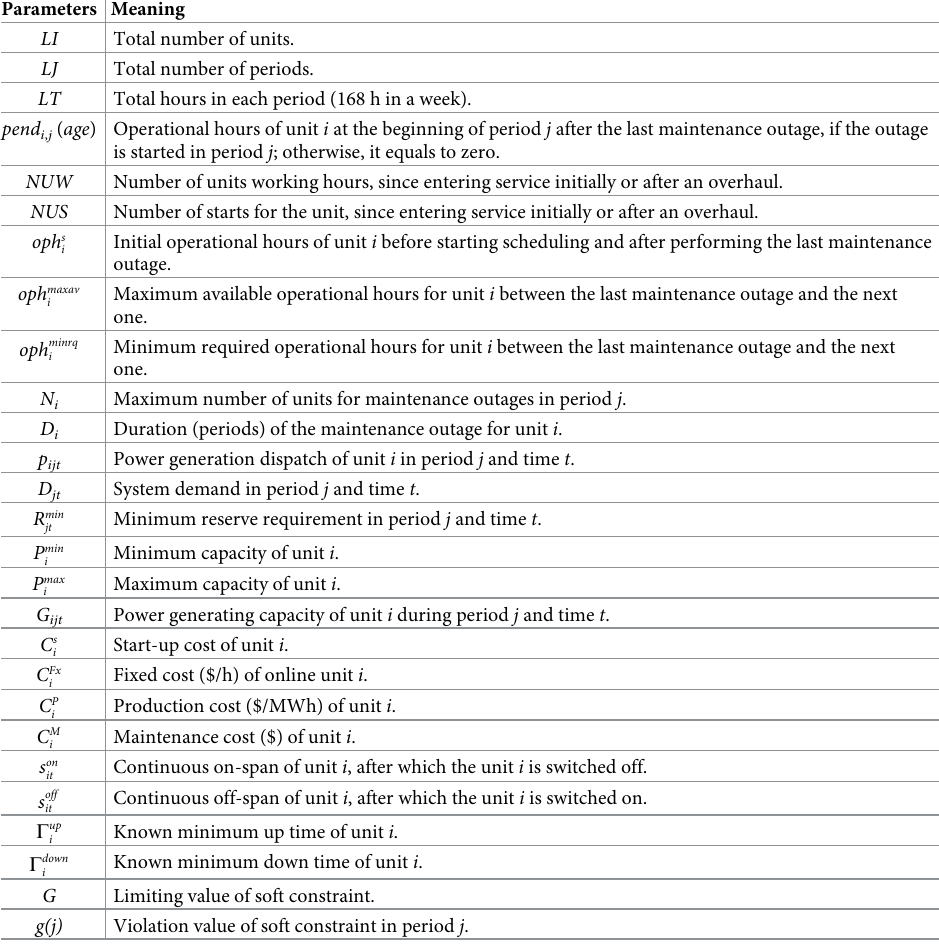
Table 3. Parameters and description. Parameters